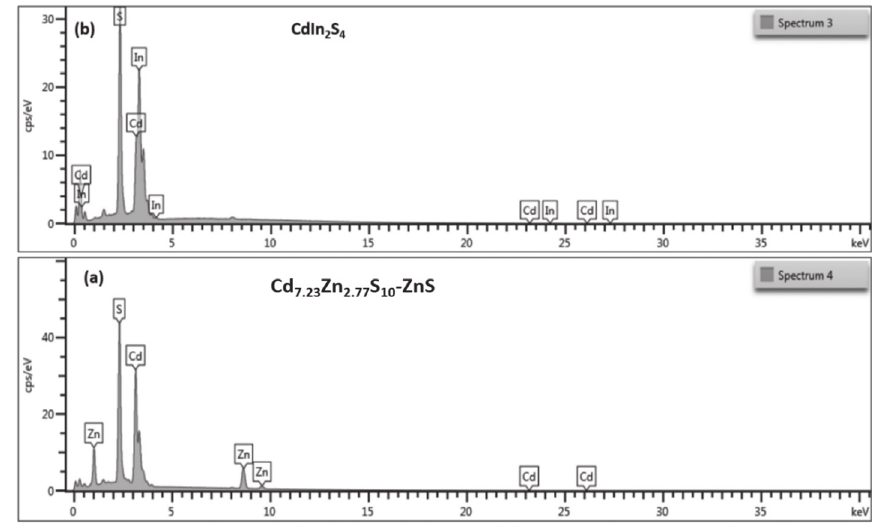
Figure A3: EDX spectra of (a) CdIn